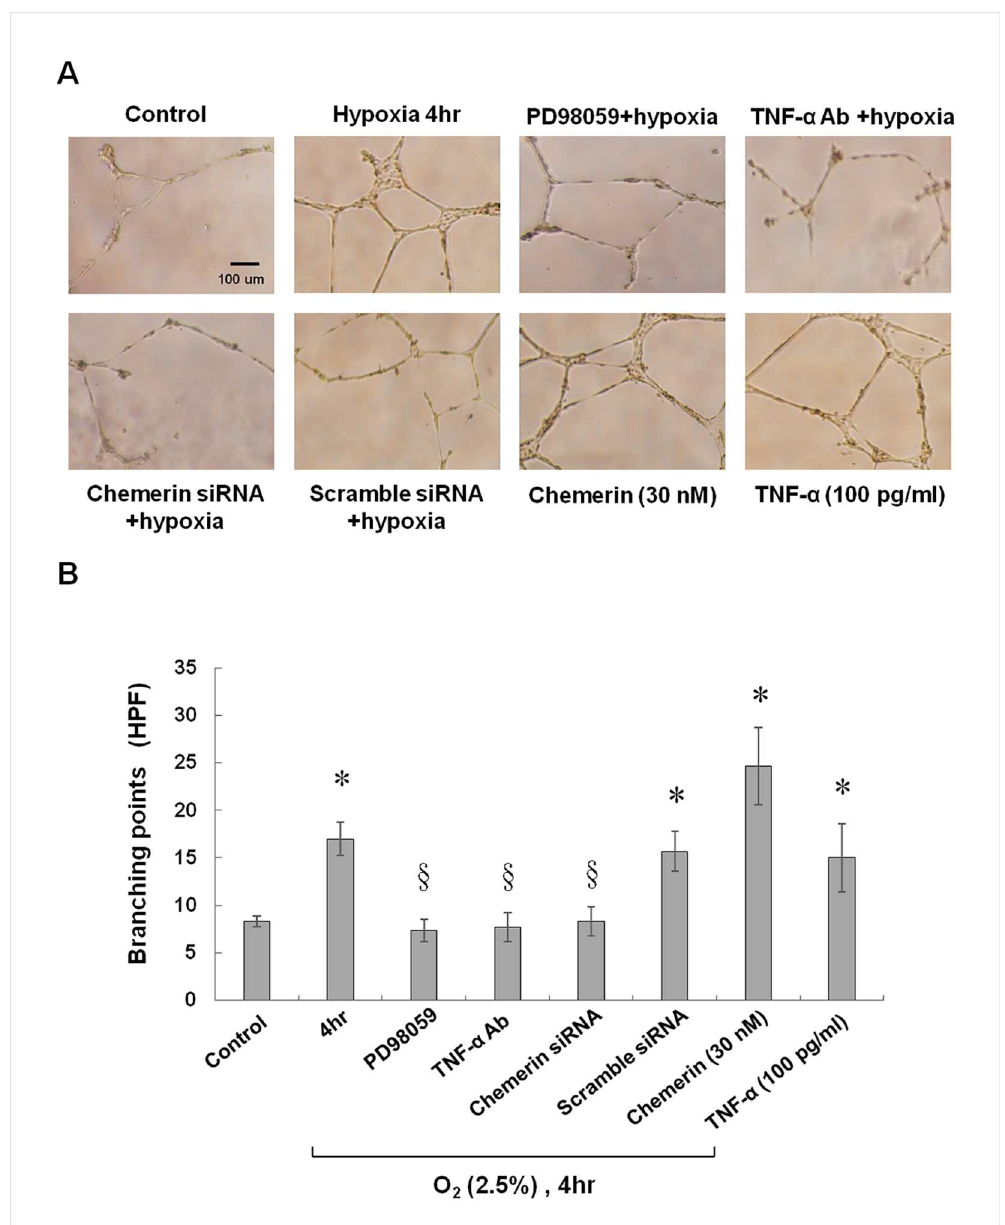
Fig 6. Effects of hypoxia on tube formation by HCAECs. (A) A representative image of a tube formed by HCAECs. (B) Quantitative branchingpoints analysis(n = 4 per group); * p < 0.01 compared to control, § p < 0.01 compared to